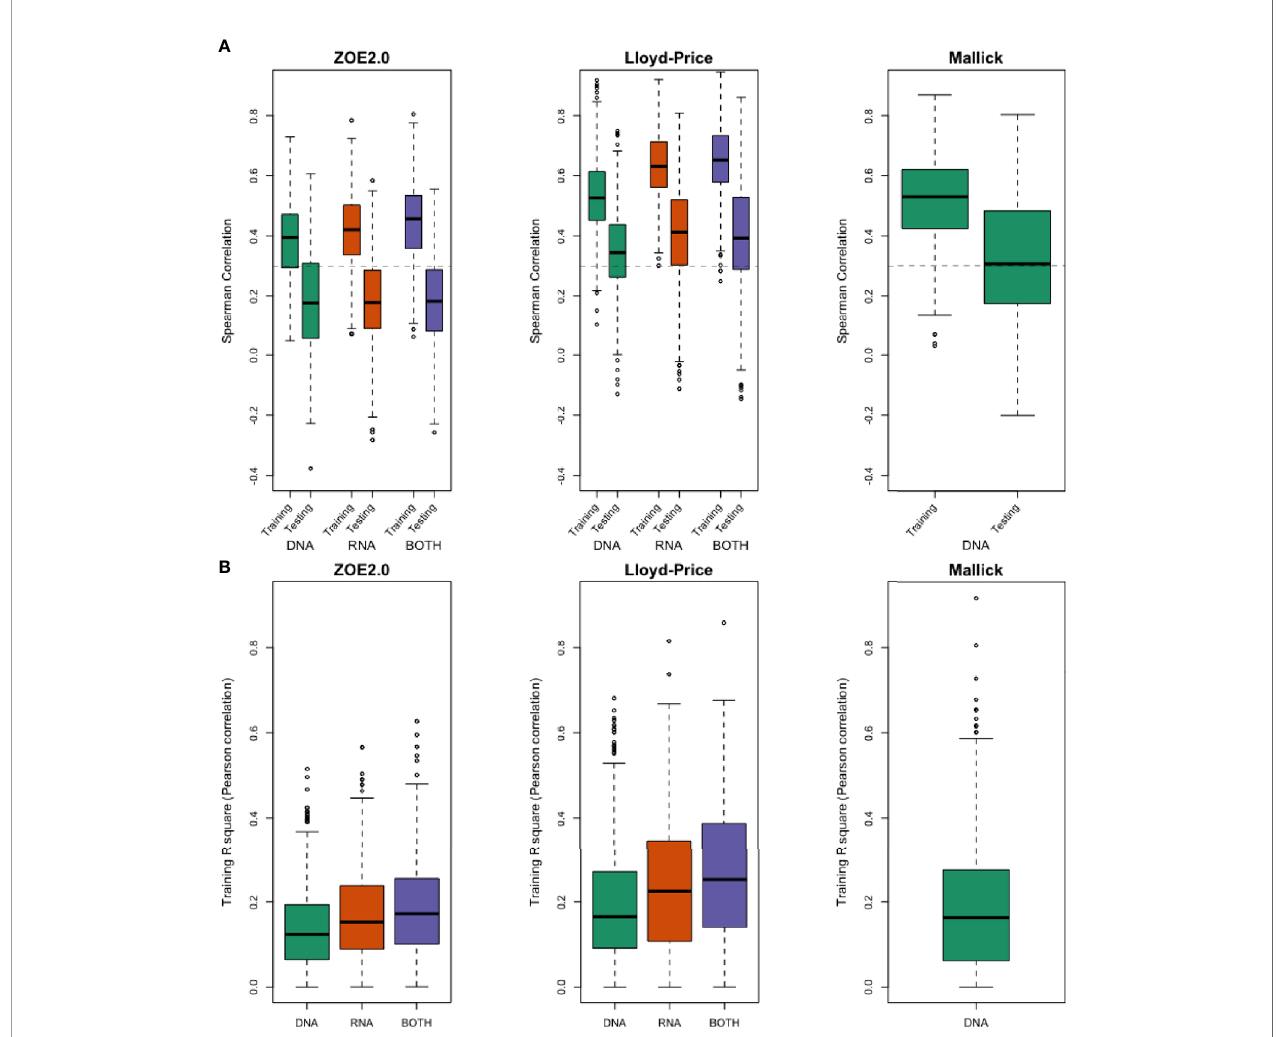
FIGURE 4 | (A) Evaluation using Spearman correlation r in training stage and testing stage between predicted values and the observed values by using DNA-seq data only, RNA-seq data only, and both for ZOE 2.0 data, Lloyd-Price data, and Mallick data. (B) R -square in the training stage, as the percentage of variance explained by prediction models to demonstrate the lack of over fi